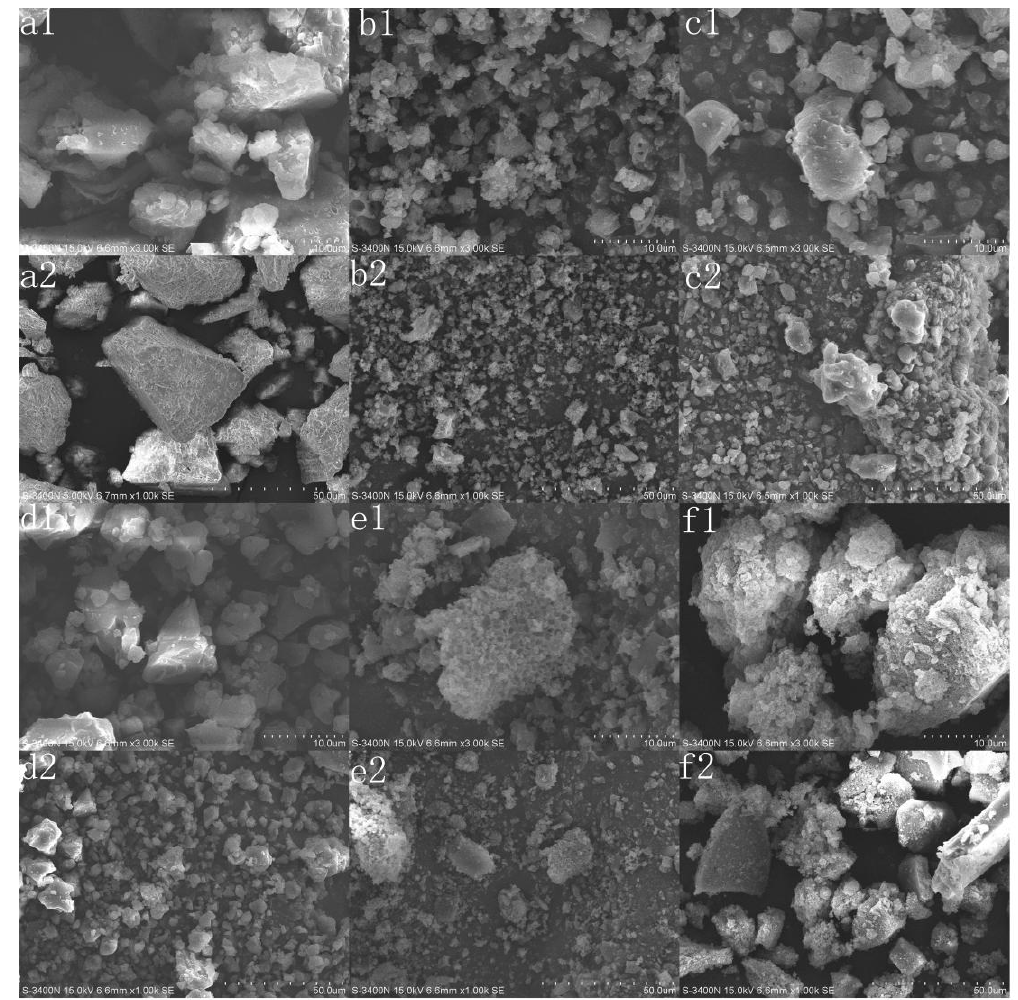
Figure 6. SEM analysis of lignin and its esters: ( a ) original lignin; ( b ) acetylated lignin (1.5 h), ( c ) propionylated lignin (1.5 h), ( d ) butyrated lignin (2 h), ( e ) succinylated lignin (2 h); ( f ) maleylated lignin (2 h).